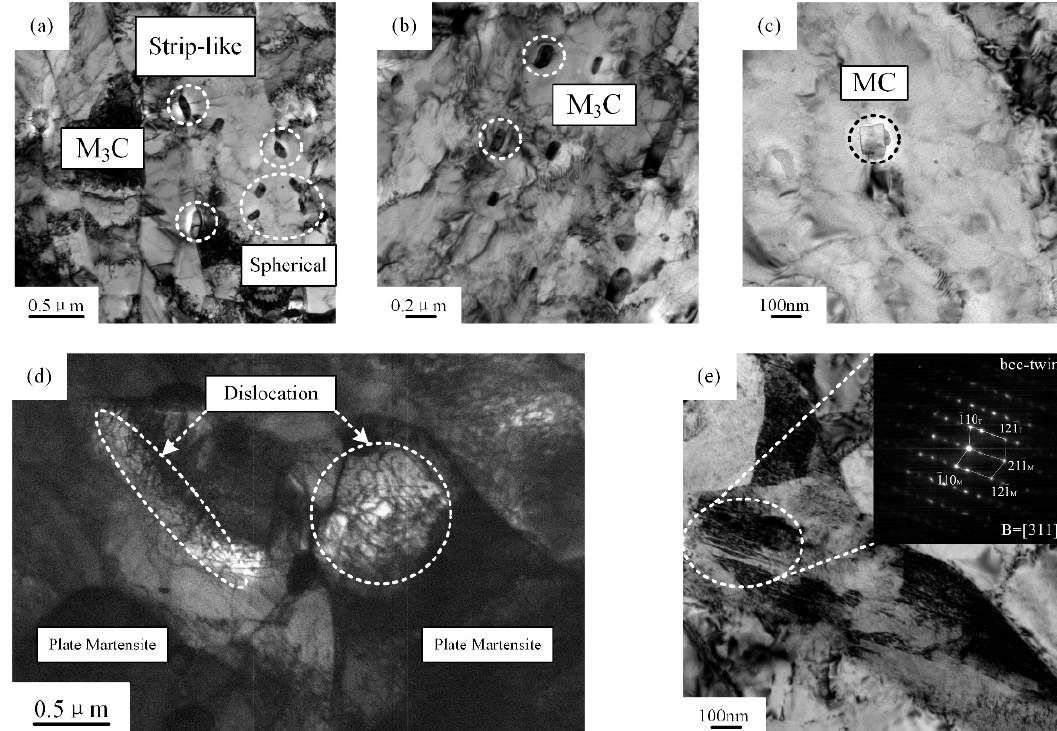
Figure 5. TEM images and selected diffraction spots of SA738 Gr.B steel after tempering at different temperatures: ( a ) 630 °C; ( b , c ) 650 °C; ( d ) 690 °C; ( e ) 710 °C.